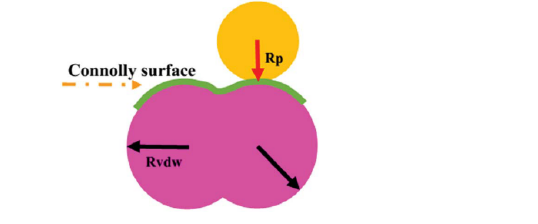
Figure 12. A schematic diagram for calculating free volume [67].